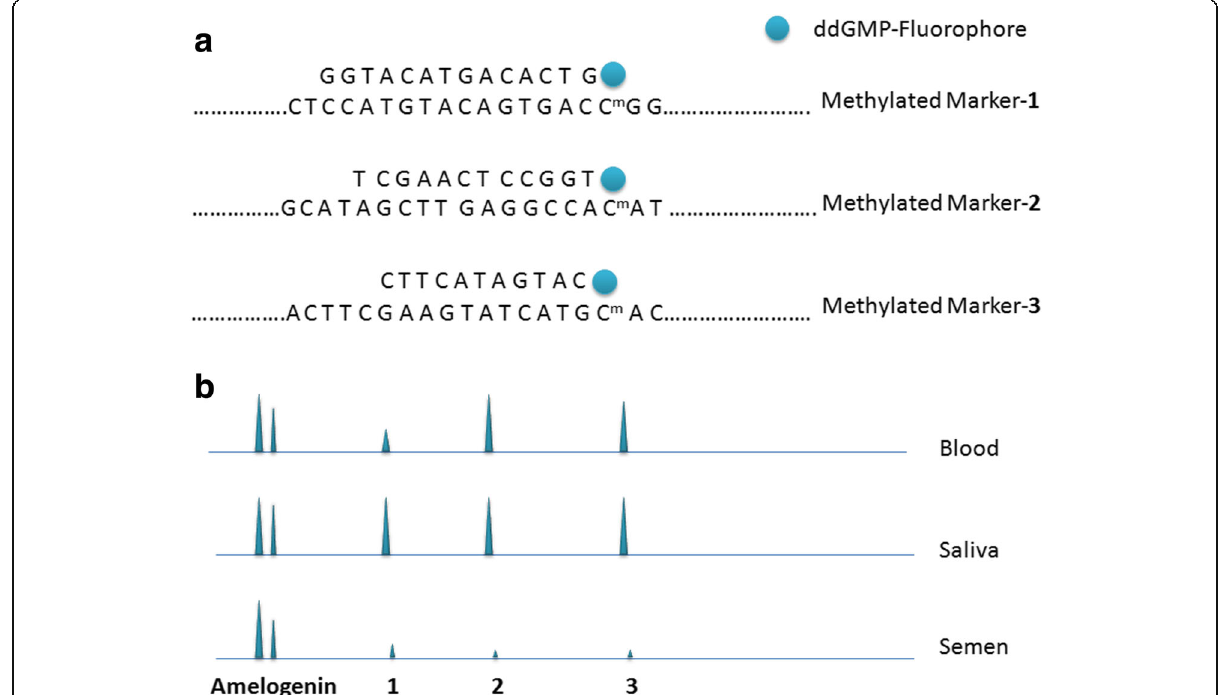
Fig. 4 Schematic representation of Methyl-sensitive Single Nucleotide Primer Extension (Ms-SNuPE) method. a This method can be used to detect cytosine methylation by designing primers of different lengths corresponding to different cytosine markers that vary among body fluids/tissues of human (e.g. blood, saliva, and semen) or between monozygotic twins or with the ageing of human beings. The primers are extended a single base with fluorescently labeled terminators (ddNTPs-Fluorophore) using DNA polymerase b The extended primers are then detected by running these products through the genetic analyzer (capillary